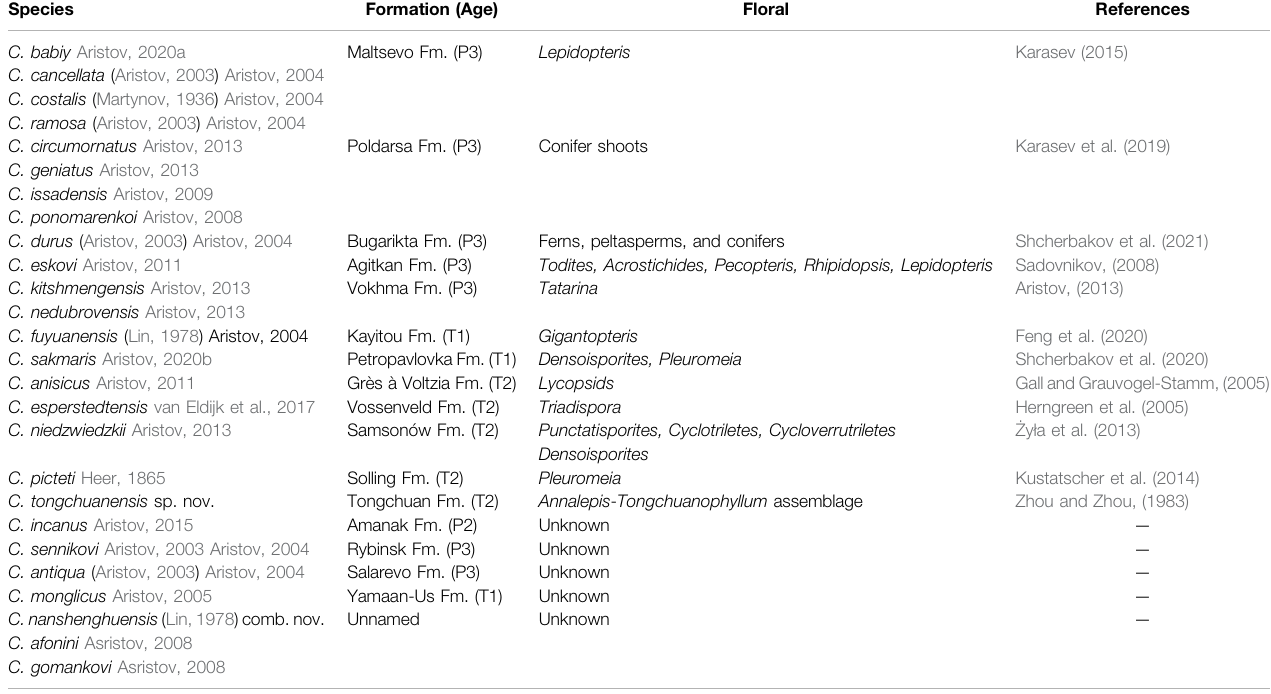
TABLE 1 | Floristic compositions of Chauliodites species bearing